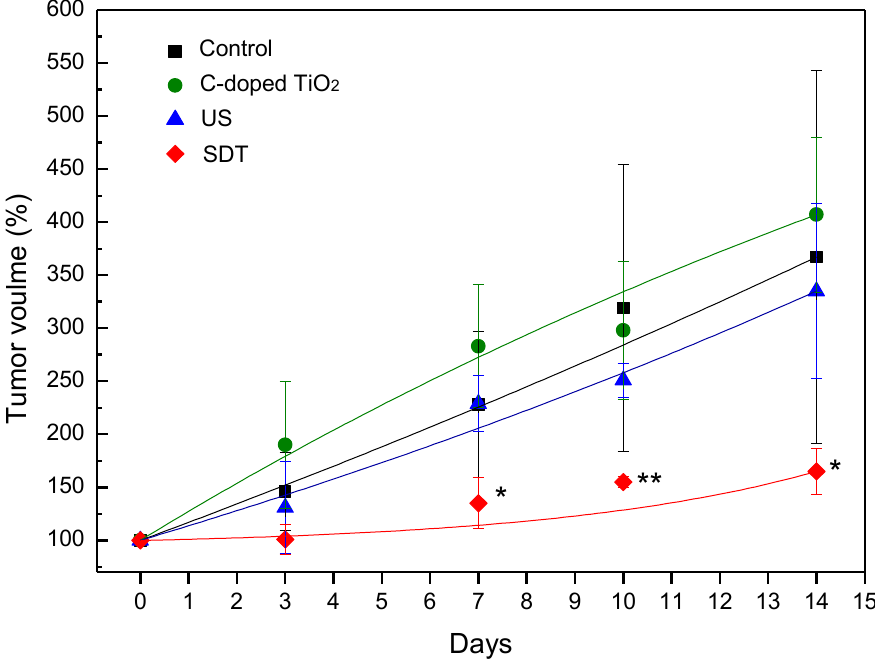
Figure 8. The variation of relative tumor volume in BALB/c nude mice induced by C-doped TiO 2 activated by US (one-way ANOVA, mean ± SD, n = 5, *: p < 0.05, **: p < 0.01).